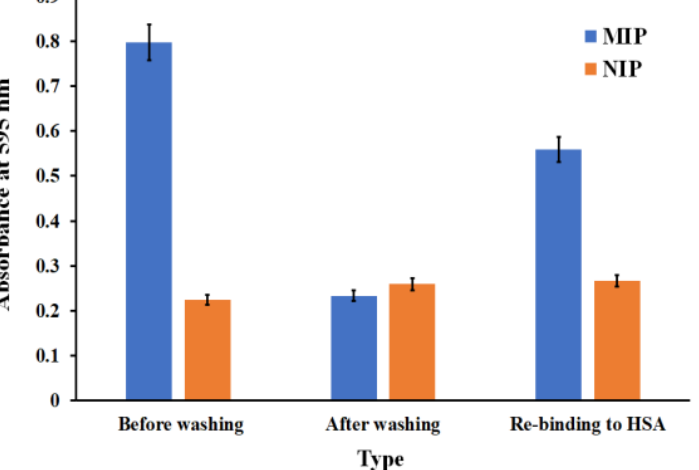
Figure 4. Absorbance of HSA-MIP (AA/VP ratio 2:3 ( w / w )) before removing the template, after removing the template, rebinding with HSA at concentration of 5 g/dL, and the corresponding NIPs. The increased absorbance of NIP may be caused by the nonspecific binding of